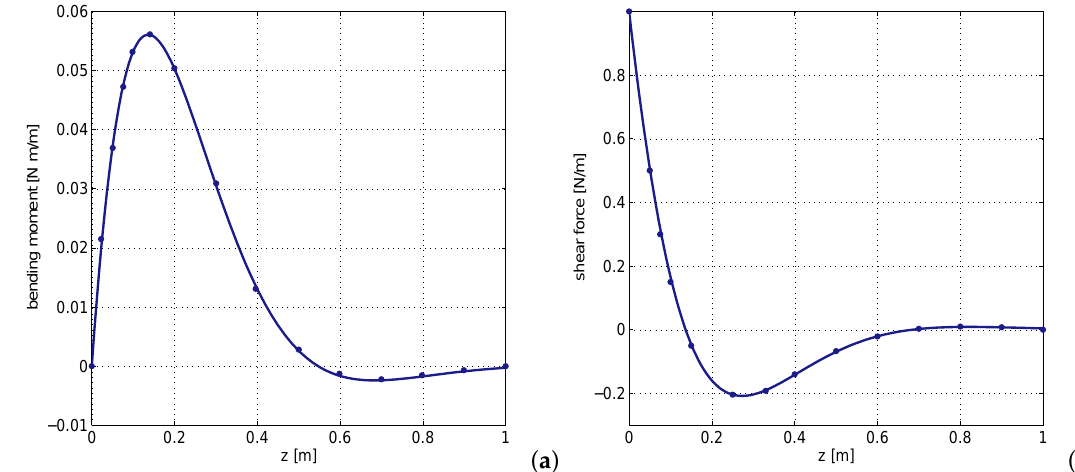
Figure 5. Cantilever cylindrical shell under tip load. ( a ) Bending moment M 11 : blue solid line—present results vs. blue bullets—reference results [55]. ( b ) Shear force Q 11 : blue solid line—present results vs. blue bullets—reference results